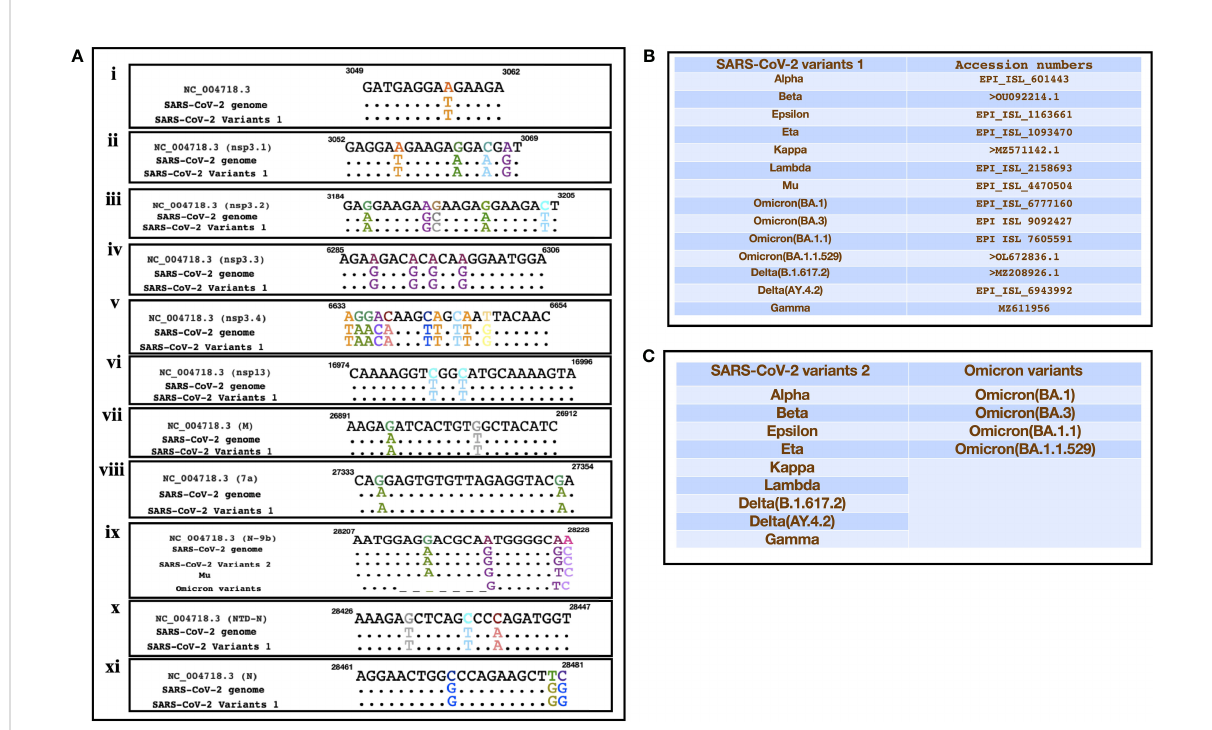
FIGURE 3 Showing the alignment of genomic regions of SARS-CoV-2 and its mutants with those regions of SARS that were shown to produce non- coding RNAs. (A) (i-xi)) represents the genomic regions where SARS encoded ncRNAs were identi fi ed (Morales et al., 2017). (B, C) Represent the sequences of SARS-CoV-2 variants that were used for the